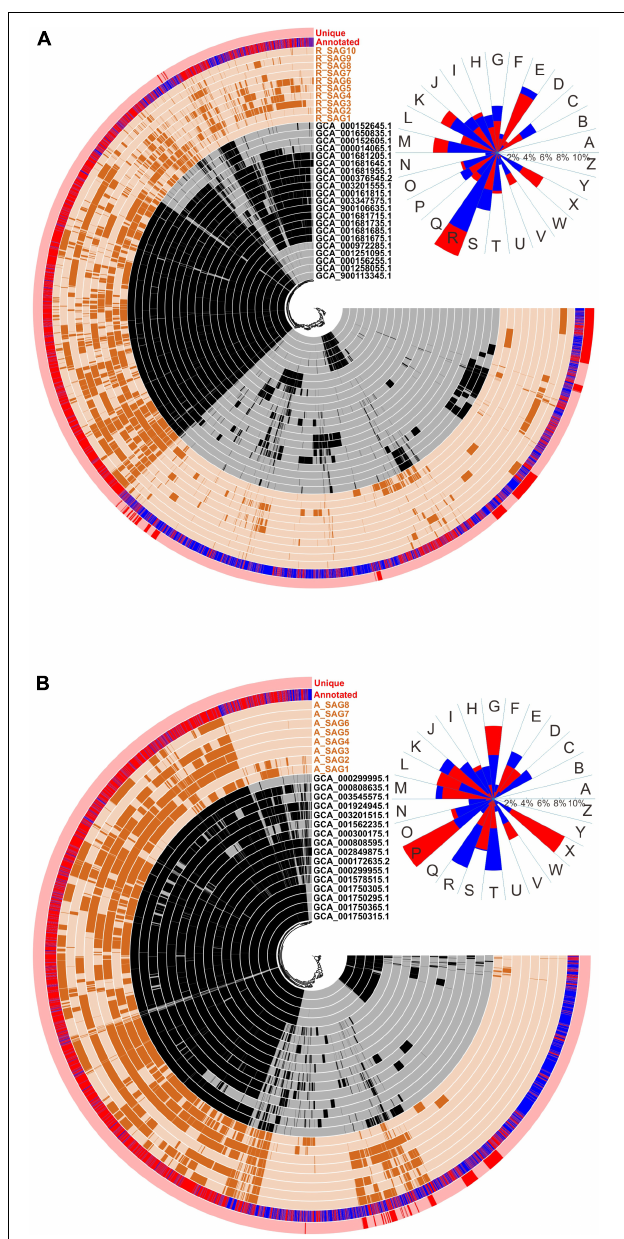
FIGURE 4 | Comparative pangenomic analysis between (A) the hadal Roseobacter SAGs or (B) the hadal Alteromonas SAGs, and the closely related reference genomes. The SAGs from this study are represented in outer circles in brown; the closely related genomes are represented in inner circles in black. Red bars in the outermost circle denote GCs unique to the hadal SAGs compared with the closely related genomes. The second most outer circle displays the COG annotation of GCs (genes with known functions are shown in red; unknown are in blue). The gene clusters are arrayed based on the hierarchical clustering (the center of each panel) of their distribution across all genomes. At the upper right corner of each panel, the functional composition of all annotated GCs (blue sectors) and GCs unique to the hadal SAGs (red sectors) are shown, based on the following COG categories: A, RNA processing and modification; B, chromatin structure and dynamics; C, energy production and conversion; D, cell cycle control, cell division, chromosome partitioning; E, amino acid transport and metabolism;